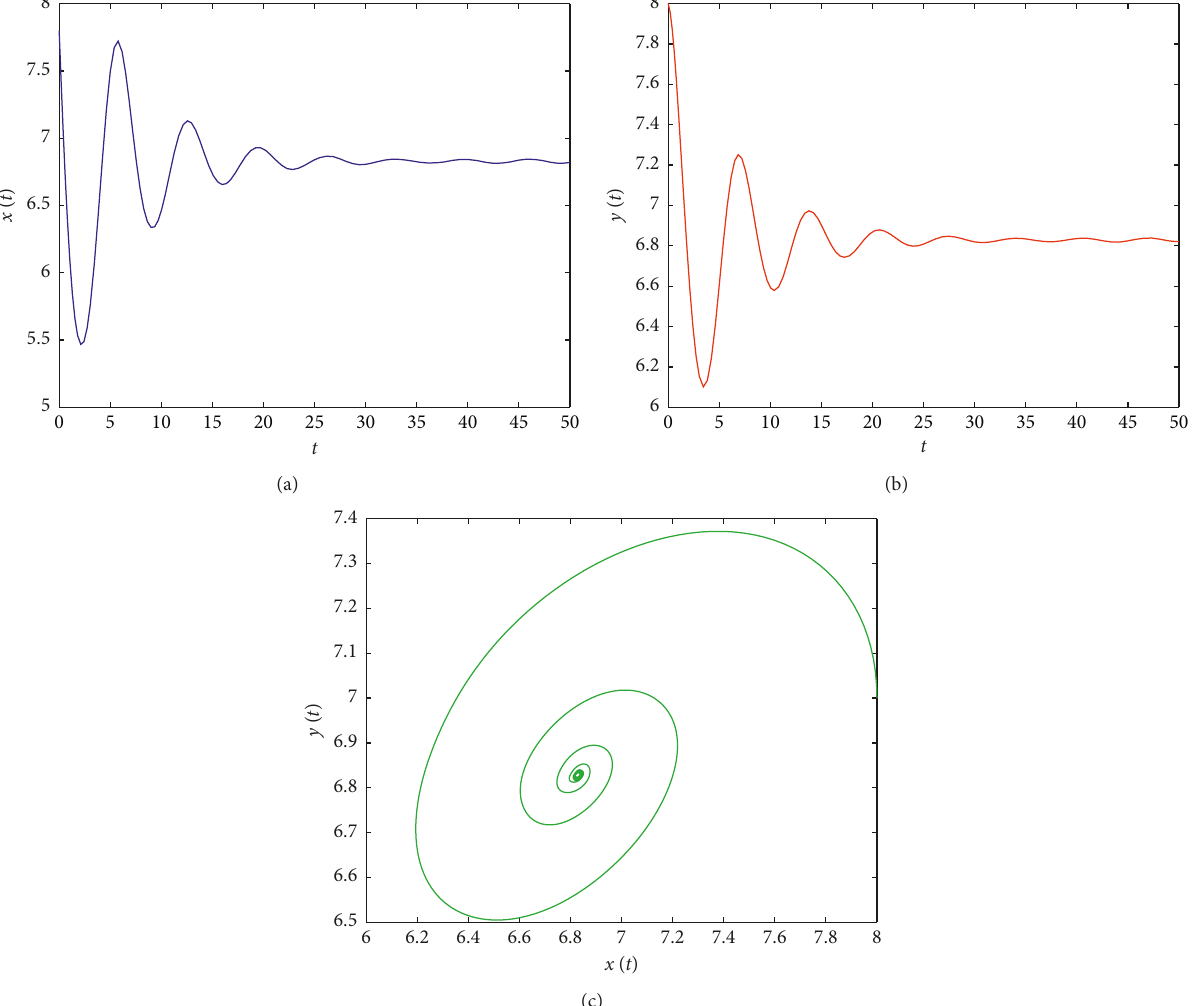
Figure 6: The time series and portrait phase of model (71) when u < Kr /4; here u � 2 , K � 8 , r � 2, and α � 0 . 6. (a) The time series of x ( t ) ; (b) the time series of y ( t ) ; (c) the portrait